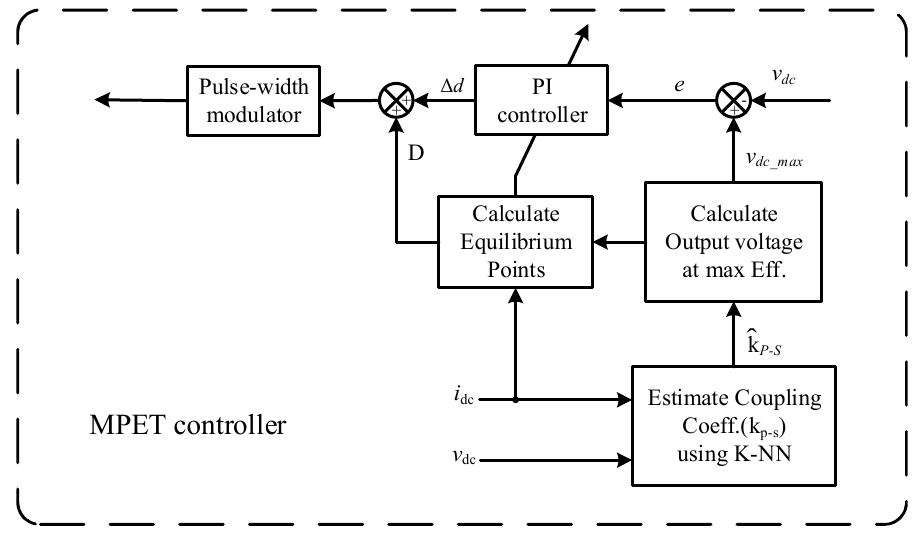
Figure 8. MPET control block.